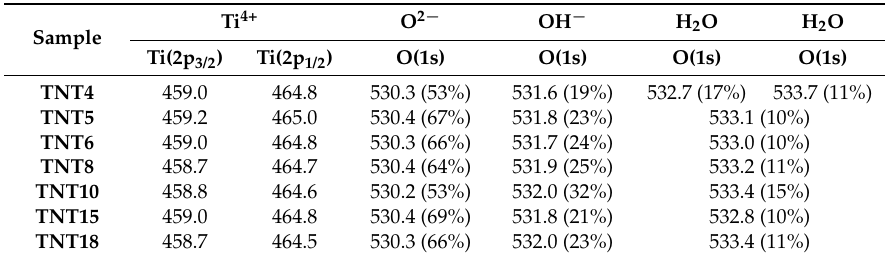
Table 1. X-ray photoelectron spectroscopy (XPS) data of selected TNT samples. The binding energies are in eV.